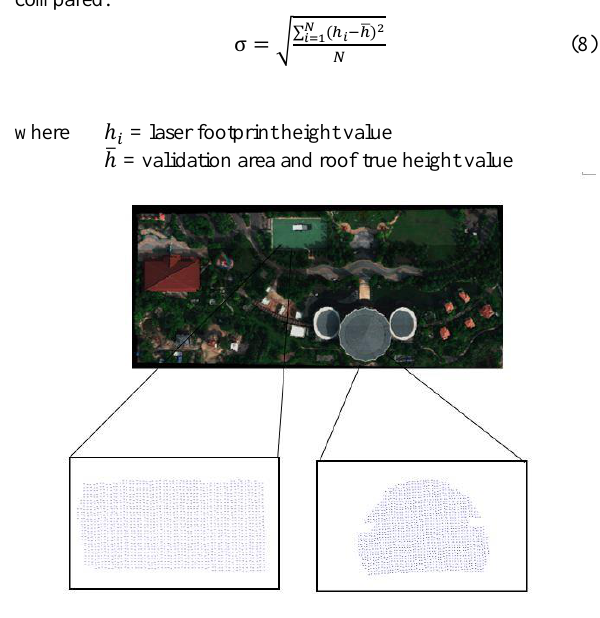
Figure 4. Validation area and roof